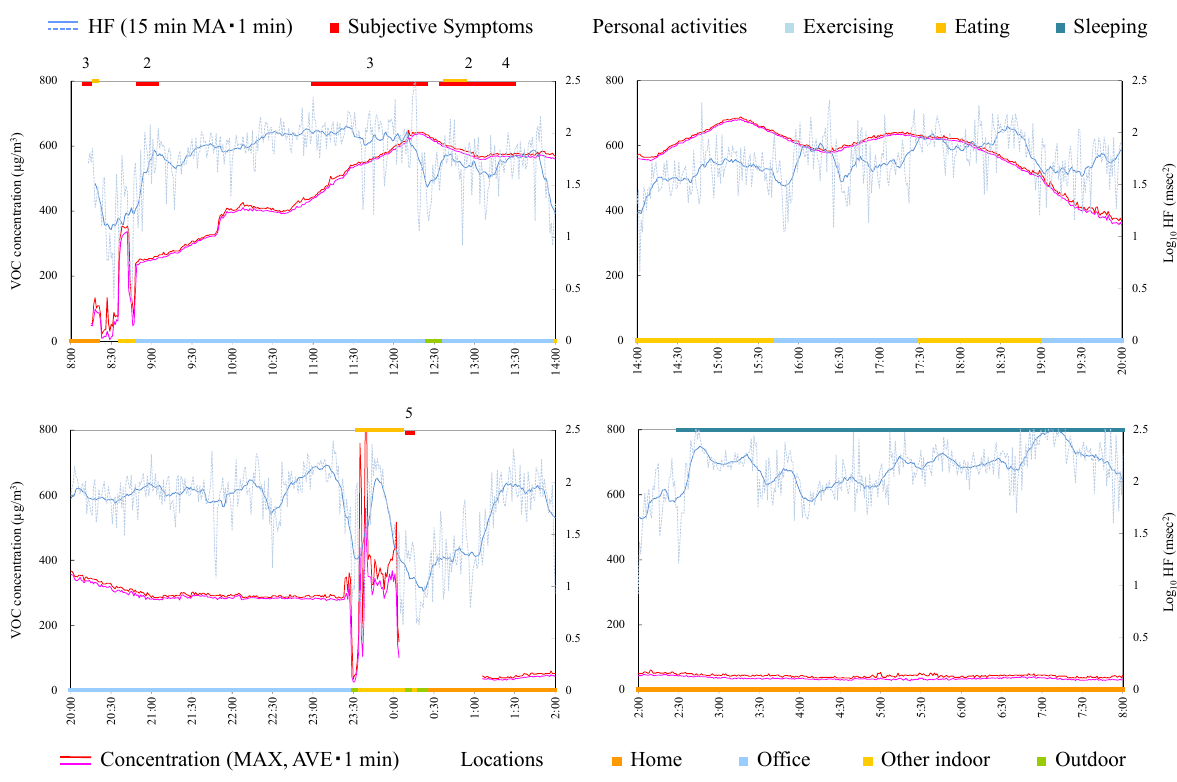
Figure 7. Time-series data of VOC concentration and log 10 HF (subject E). Subjective symptoms and personal activities are indicated in upper side and locations are indicated in lower side. The values on subjective symptoms are symptom